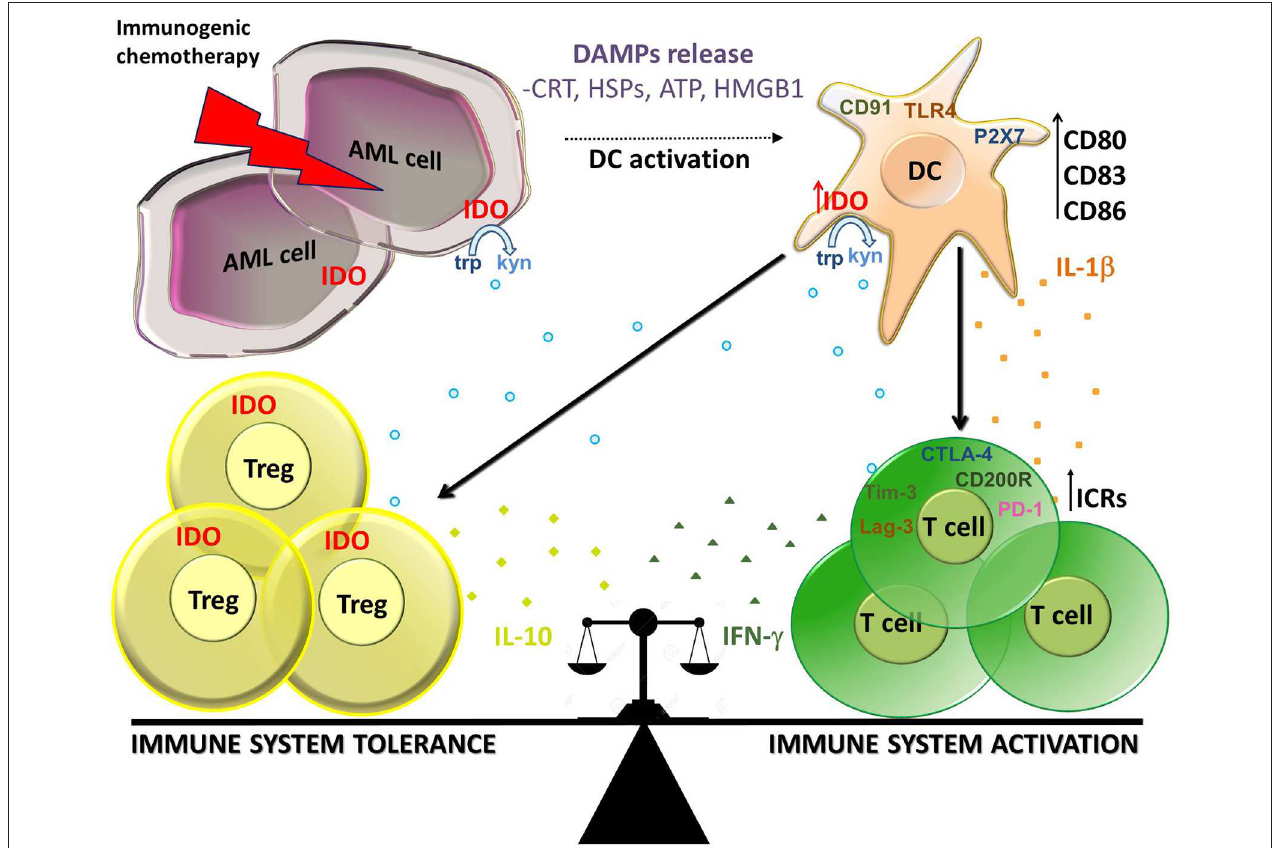
FIGURE 1 | Balance between immune activation and tolerance during ICD in AML. Immunogenic chemotherapy causes the release of DAMPs (CRT, HSPs, ATP, and HMGB1) which bind to receptors on DCs as CD91, TLR4, and P2X7. DCs up-regulate maturation markers (CD80, CD86, and CD83) and produce IL-1 β resulting in activation of T cells producing IFN- γ At the same time, DCs up-regulate IDO1 which is responsible for the production of kynurenines which in turn stimulate induction of Tregs producing IL-10 and inhibit effector T cells. IDO1 is expressed also on AML cells and Treg cells, thus participating to the suppressive local milleu. Immune check points receptors (ICRs) as PD-1, Tim-3, Lag-3, CD200R, and CTLA-4 can contribute to the cell composition of tumor microenvironment. In this context, IDO1 seems to play a key role in the balance between immune system activation and tolerance in AML during